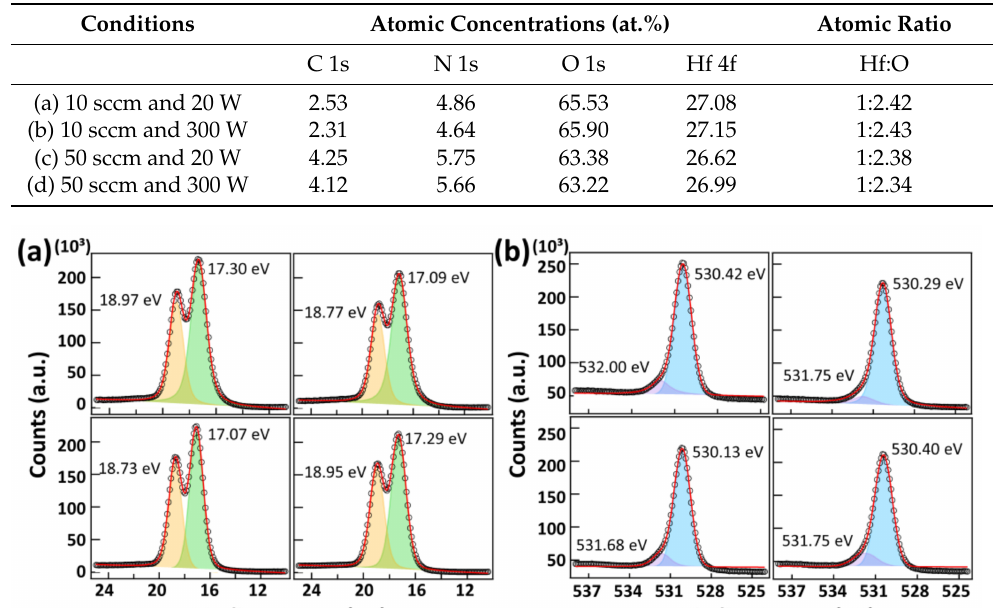
Table 2. Atomic concentrations of Hf, O, C, and N in HfO 2 films deposited at different O 2 flow rates and O 2 plasma power.